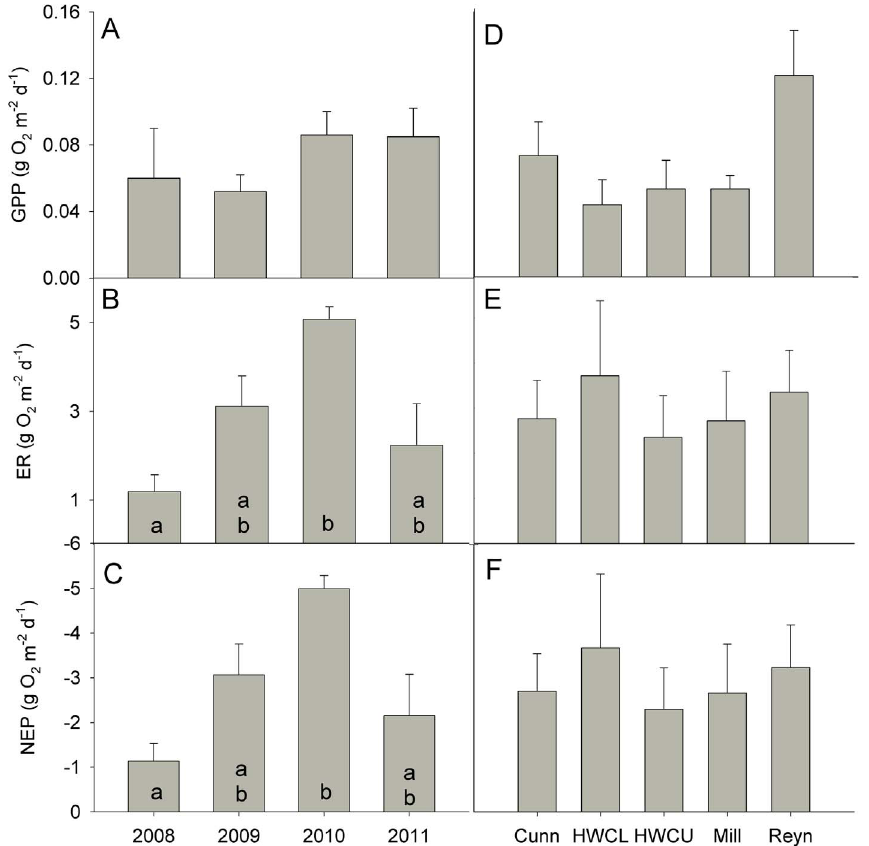
Figure 3. Metabolic parameters in Coweeta streams. Changes in gross primary production (GPP), ecosystem respiration (ER), and net ecosystem production (NEP) for low-order streams in Coweeta Hydrologic Laboratory over the years of the study (A–C) and in each stream (D–F). Error bars represent 1 SE of the mean, and different letters represent significant differences (p , 0.05) based on Wilcoxon post-hoc multiple comparison tests.